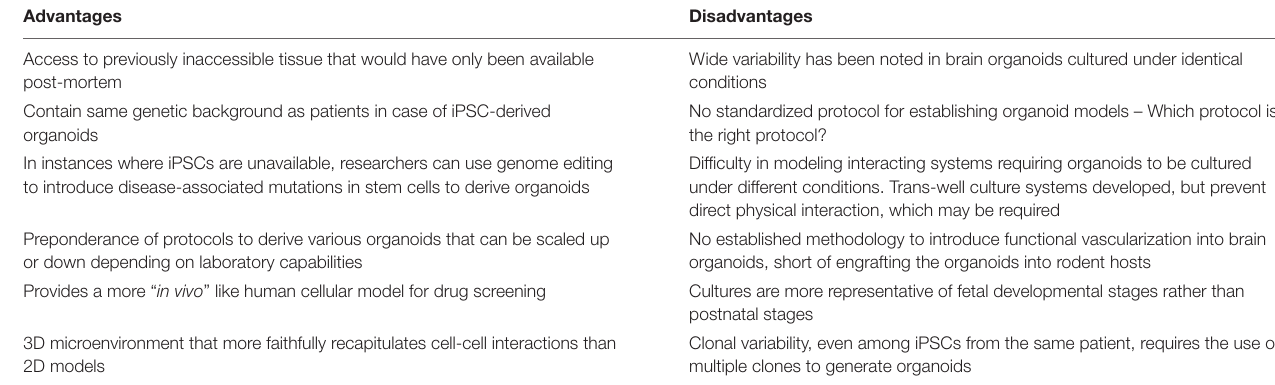
FIGURE 1 | Investigating interactions between multiple systems using organoid co-culture systems. Mechanisms underlying the neuro-immune, neuro-endocrine, and gut-brain axis in humans can be investigated utilizing organoid co-culture systems. Advances have already been made in the use of brain region specific organoids co-cultured with microglia (resident immune cells in the brain) in the study of ZIKV induced microcephaly and Alzheimer’s disease. Similarly, advances in the development of blood brain barrier (BBB) stem cell models highlights the exciting possibility of investigating the role of the BBB thinning in AD pathogenesis. Enteric organoids that combine intestinal (HIOs) and enteric nervous system (ENS) cellular components and vagal sensory neurons suggest the possibility to interrogate the mechanisms underlying the gut-brain interactions in vitro . Finally, the development of different organoid models of human pituitary and hypothalamic tissue has also been reported. Even though to date there is no organoid model of the adrenal gland, this could potentially be used to interrogate different components of the neuro-endocrine axis. (Figure was created with BioRender.com softwared. Abbreviations used w/wo is with or without). TABLE 1 | Advantages and disadvantages of organoid